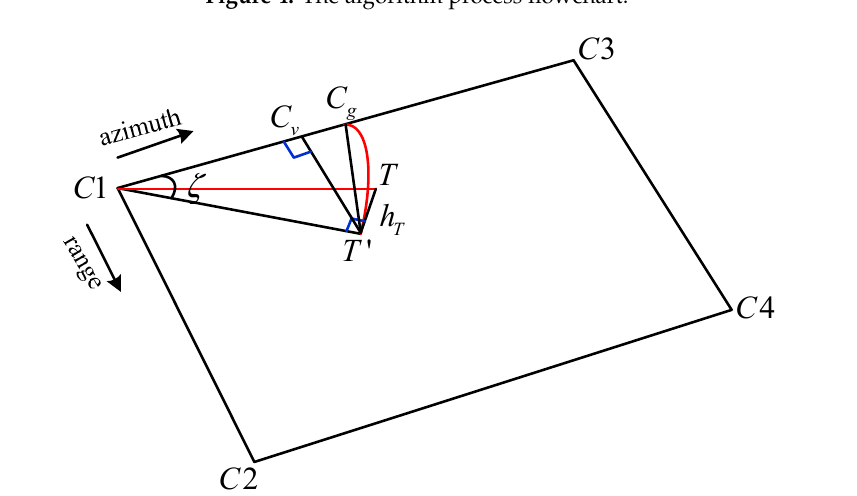
Figure 4. The algorithm process flowchart.